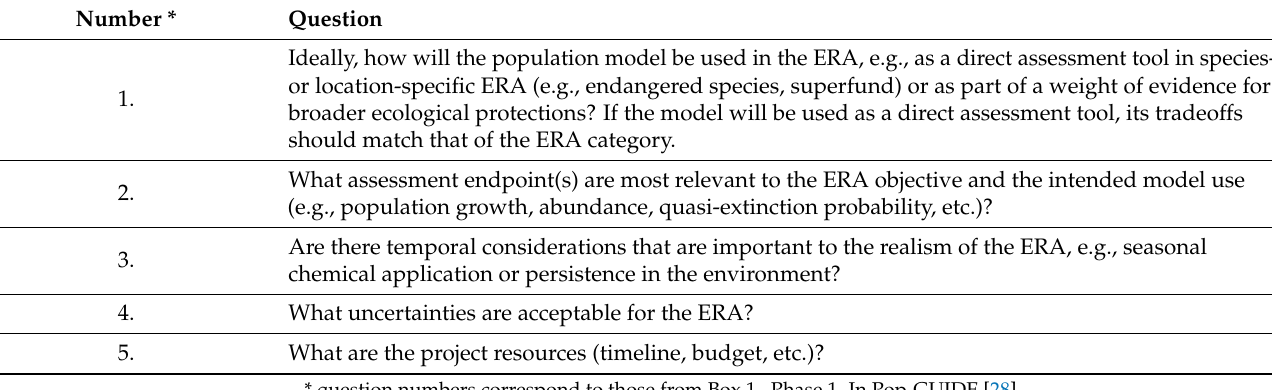
Table 1. Phase 1 questions to derive model